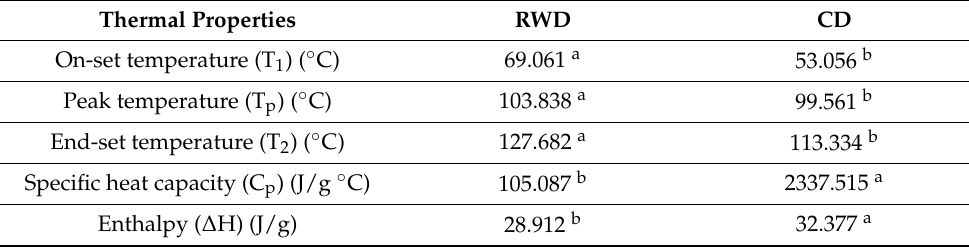
Table 6. Thermal properties of RW- and convective-dried onion